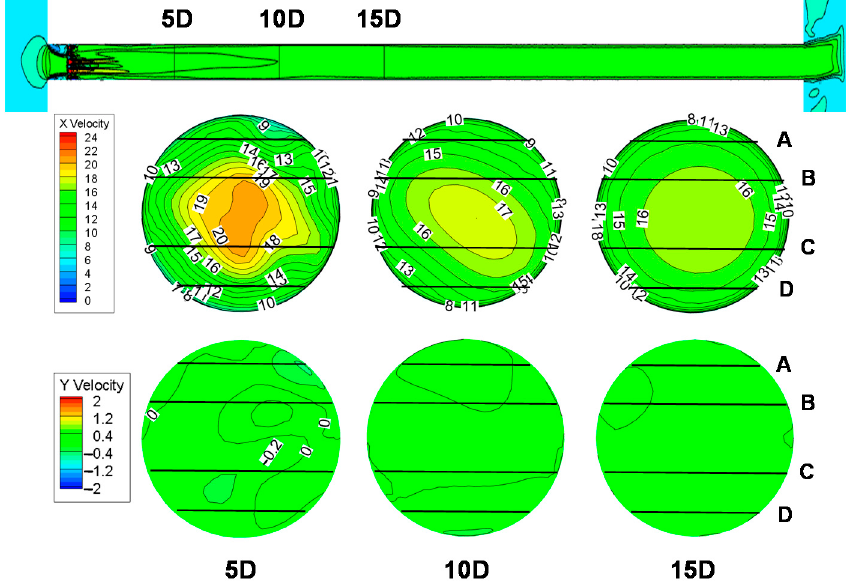
Figure 16. Contours of velocity profiles on the different cross-sections downstream of the header with FC.